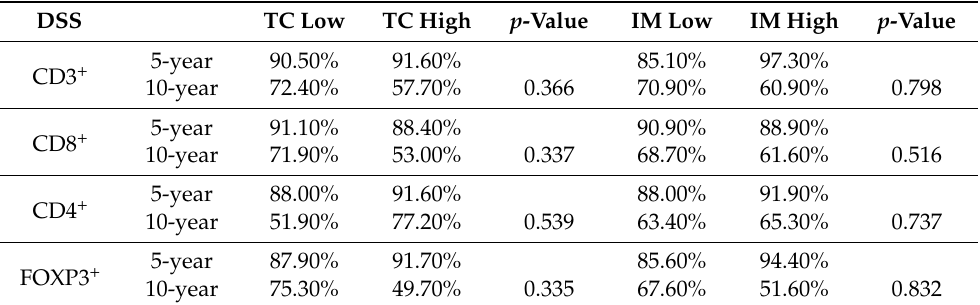
Table 5. Disease-specific survival (DSS) rates according to dichotomized (based on median values) CD3 + , CD8 + , CD4 + and FOXP3 + T cell densities at the tumor center (TC) and at the invasive margin (IM) in small bowel neuroendocrine tumor lymph node metastases. DSS TC Low TC High p -Value IM Low IM High p -Value CD3 +